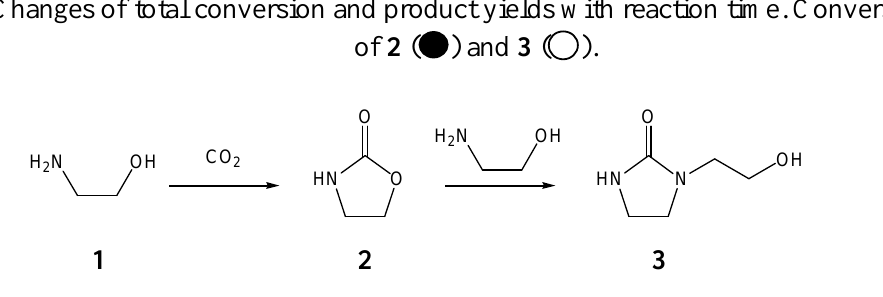
1 2 3 Scheme 2. Consecutive transformation from 2-aminoethanol 1 to 2-oxazolidinone 2 and then to 1-(2- hydroxyethyl)-2-imidazolidinone 3